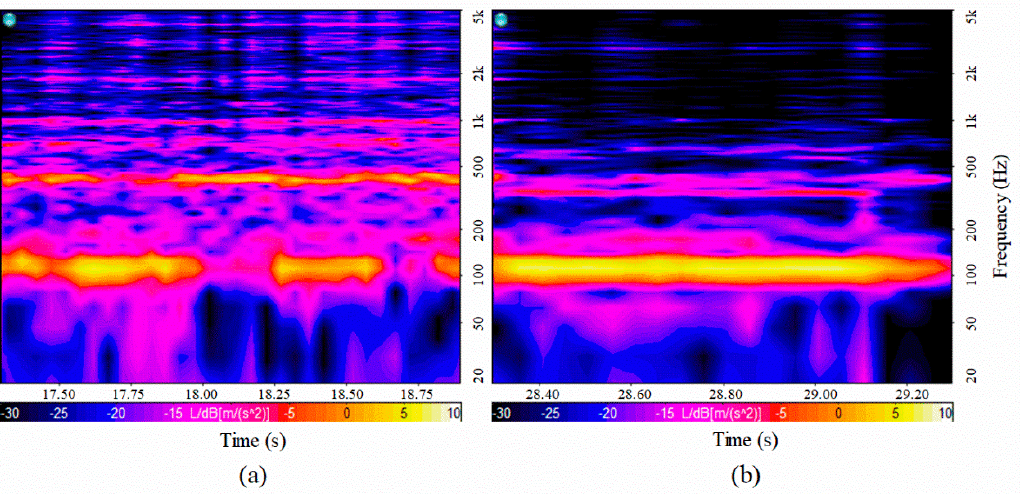
Figure 8. Comparison of gauge plate vibration using an STFT depending on the different flow velocities: ( a ) 1.35 and ( b ) 1.03 g/s.